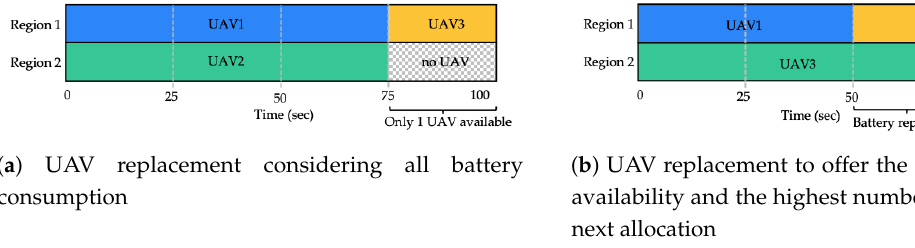
Figure 4. Differences between the analysed scheduling procedures. Example for j = 2 and i = 3 (2 UAVs in services and 1 UAV for